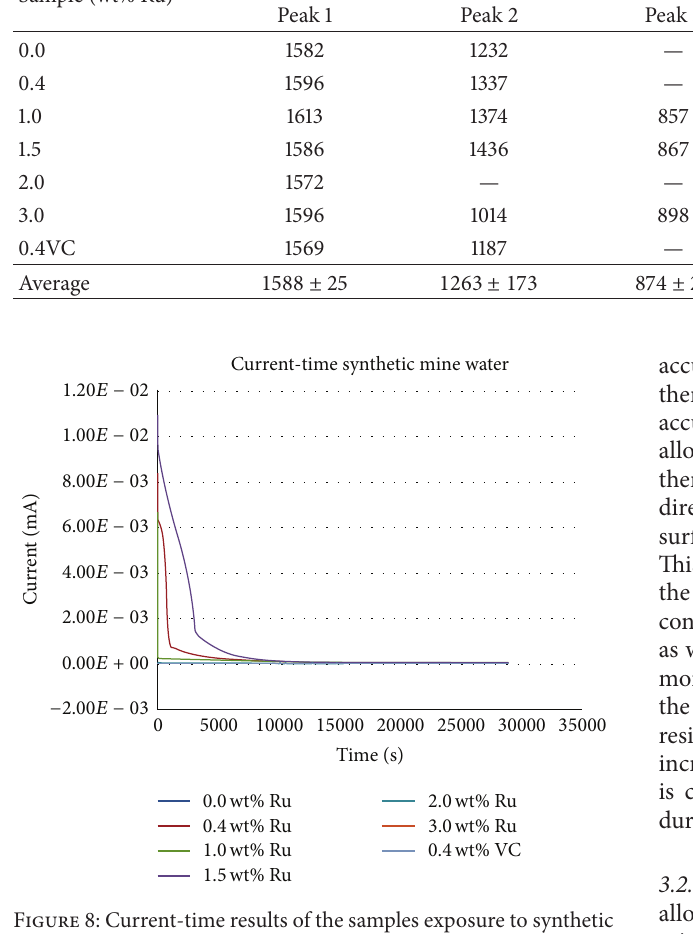
Table 6: Raman peak positions (cm − 1 ) found on the surface of WC-Co-Ru/VC alloys after exposure in synthetic mine water solution. Sample (wt% Ru)